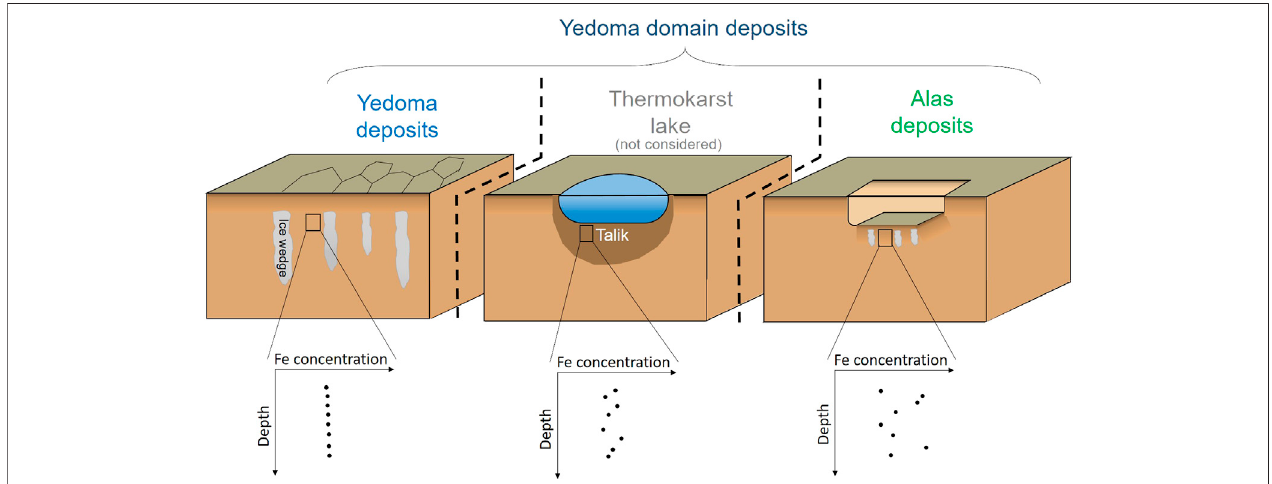
FIGURE 7 | Conceptual scheme of the depth-distribution of total Fe concentration in never thawed Yedoma Ice Complex deposits, in deposits subsequently to thaw processes, i.e., below thermokarst lake (not considered in this study) and in Alas deposits. Black rectangles in the upper schematic representation of Yedoma, thermokarst lake and Alas pro fi le indicate the sample location. The spatial coverage of the geomorphologic features is not to scale.